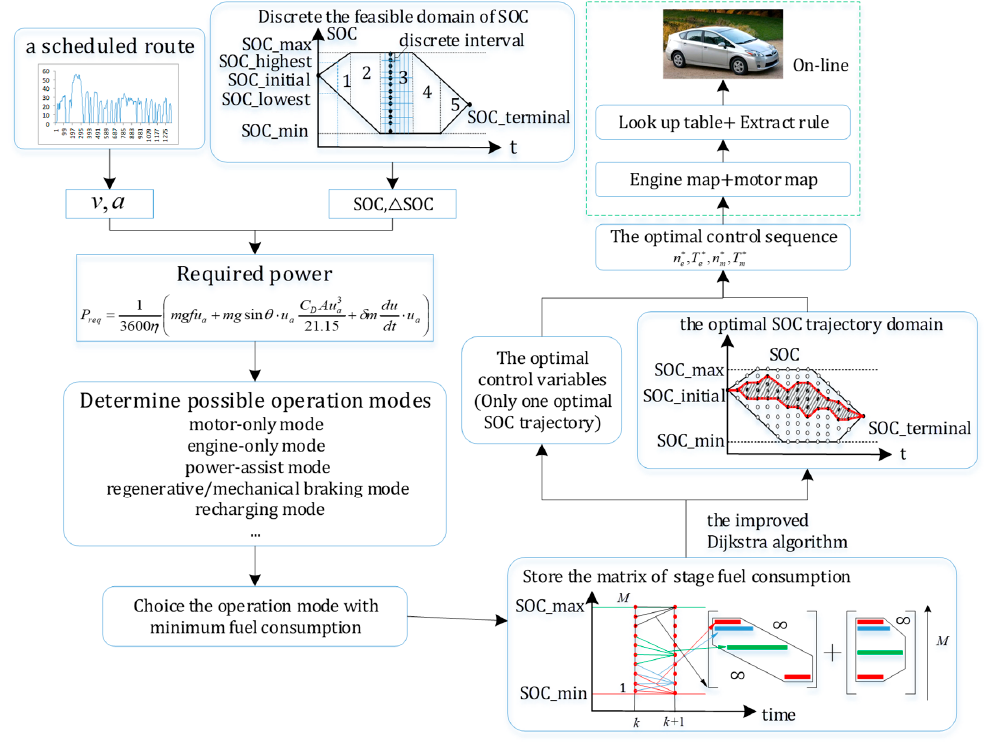
Figure 7. Depiction of the main technical areas of the DDP-based strategy.